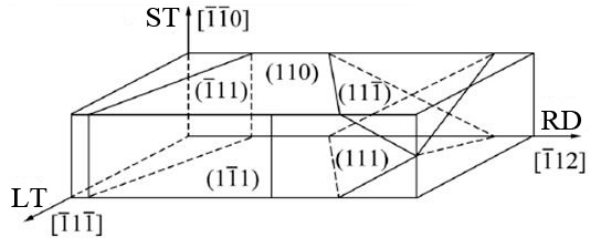
Figure 8. Space relationships of four possible {111} slip planes with the Brass orientation {110}<112>. Table 2. Schmid factors of the slip system {111}<110> for various tensile orientations. Slip Plane Slip Direction